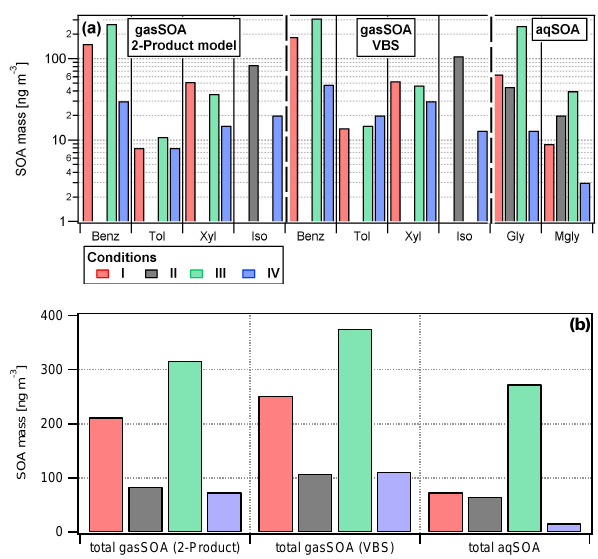
Fig. 7. Comparison of predicted gasSOA and aqSOA masses from various precursors in the presence of [OH] = 10 6 cm − 3 over 12h for the conditions as specified in Table